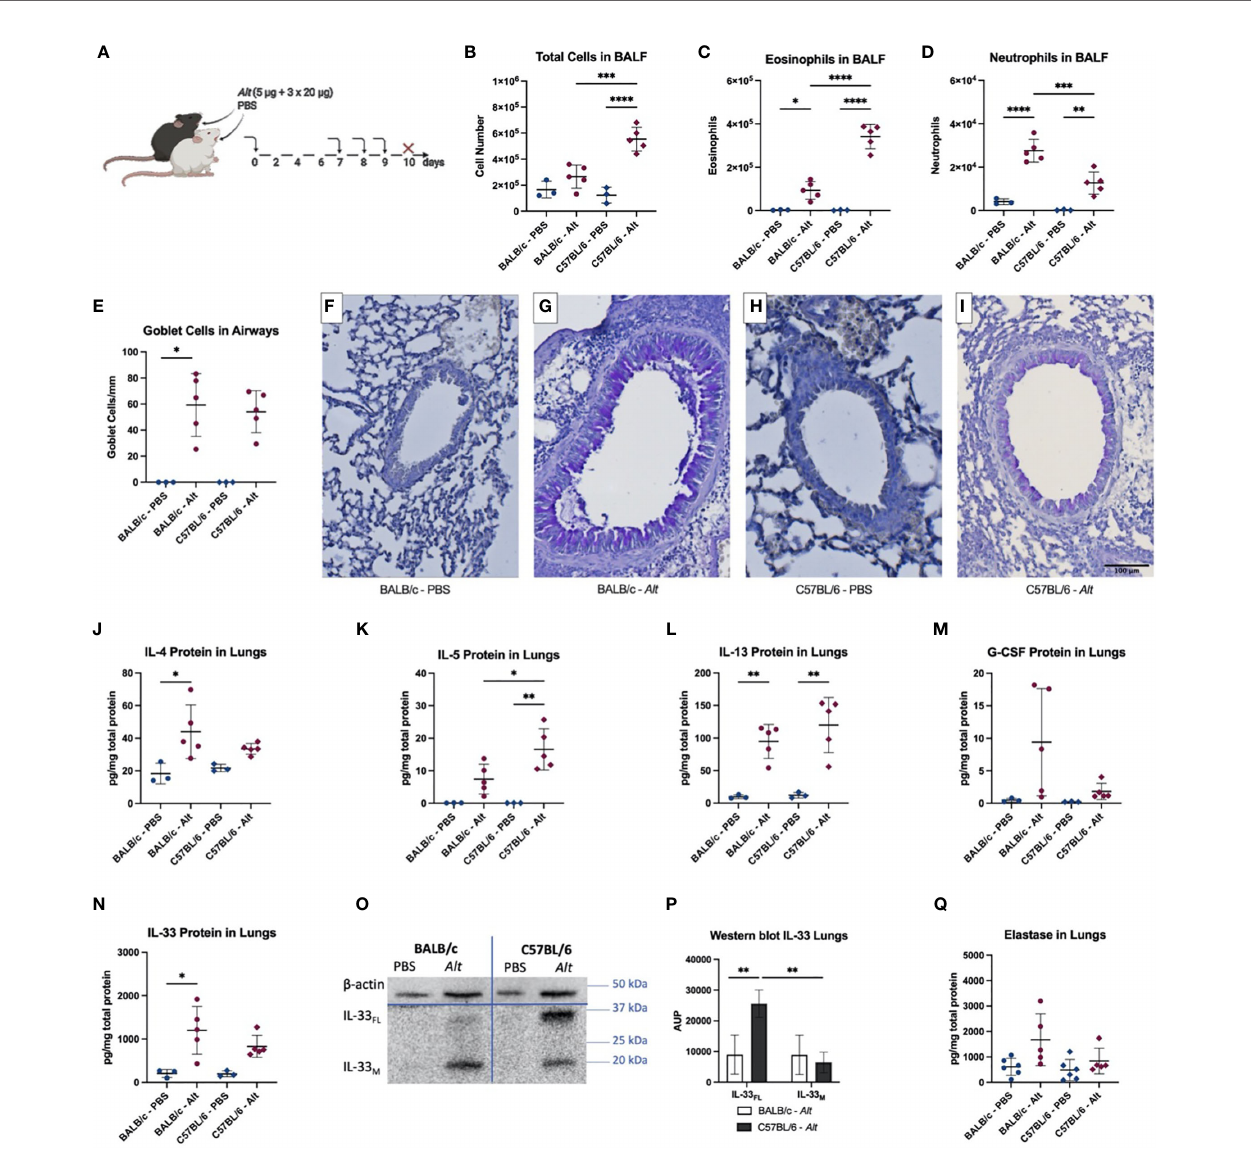
FIGURE 2 | BALB/c and C57BL/6 mice were sensitized with one intratracheal (i.t.) application of 5 µg Alternaria alternata ( Alt) extract or PBS. On days 7, 8 and 9 the mice were challenged i.t. with 20 µg Alt extract or PBS. Twenty-four hours after the application mice were euthanized, and samples were collected (A) . The total cell count (B) , eosinophils (C) and neutrophils (D) in BALF determined by fl ow cytometry. Quanti fi cation of goblet cells in the larger airways (E) and representative images of PAS-staining for the groups BALB/c – PBS (F) , BALB/c – Alt (G) , C57BL/6 – PBS (H) and C57BL/6 – Alt (I) . The levels of IL-4 (J) , IL-5 (K) , IL-13 (L) , G-CSF (M) and IL-33 (N) were analyzed in lung homogenates by Luminex. Full-length IL-33 (IL-33 FL ) and mature forms (IL-33 M ) were analyzed by western blotting and area under the peak (A.U.P.) was quanti fi ed using ImageJ software (P) . One representative blot is shown (O) . Elastase protein levels in the lungs are shown in (Q) . n=3-5. Data is presented as mean ± SD, *P < 0.0332; **P < 0.0021; ***P < 0,0002; ****P <